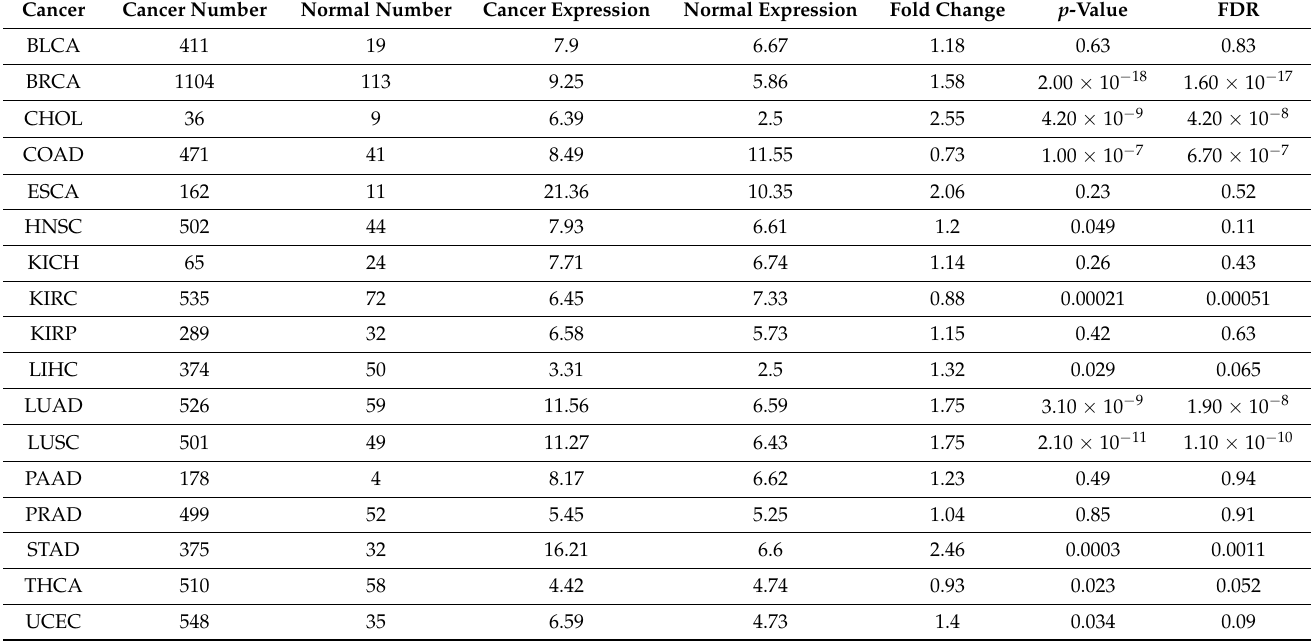
Table 2. KRAS expression in different cancer